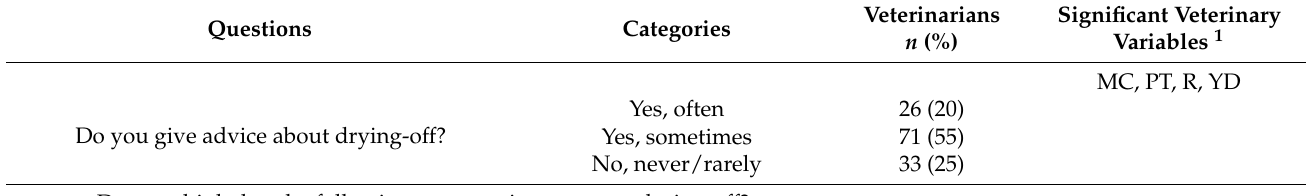
Table 2. Answers to questions about giving advice regarding drying-off of dairy cows to farmers and personnel given by veterinarians ( n = 130) responding to a web-based questionnaire. Associations between veterinary variables and the answers were investigated by univariable regression models. If significant ( p ≤ 0.05) the herd variables are presented (see Supplementary Table S3 for